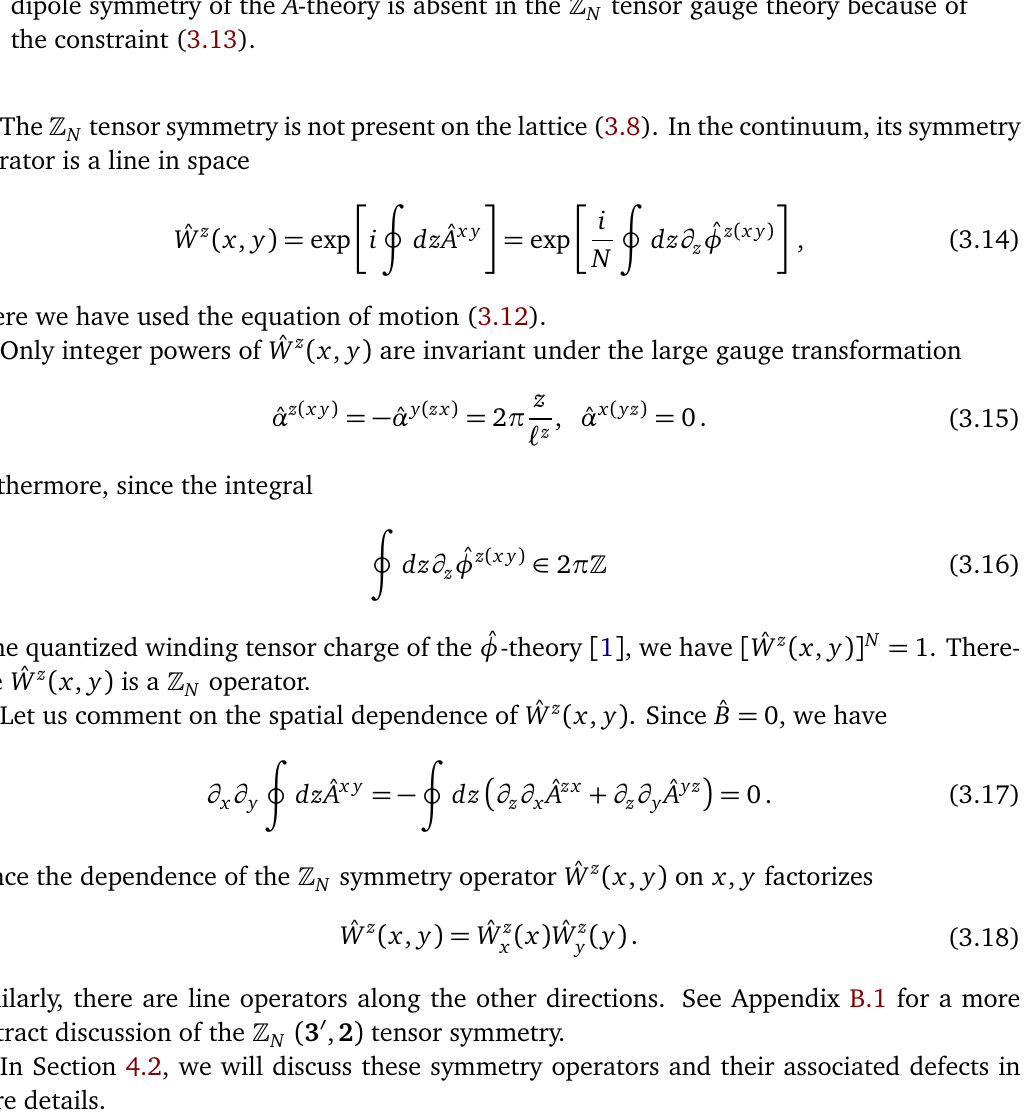
tensor N tensor gauge theory. The magnetic N tensor gauge theory because of N